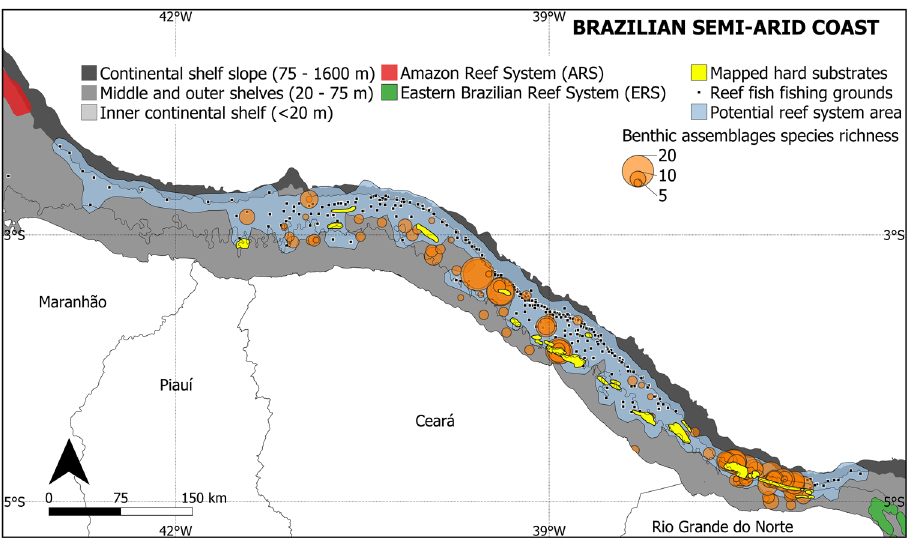
Figure 2. Distribution of euphotic and mesophotic hard-bottom habitats along the Brazilian semi-arid coast (Tropical SW Atlantic). Location data for benthic assemblages (including octocoral, scleractinian, and sponge grounds typically with reef fish assemblages) and fishing grounds obtained from the literature, scientific collections, and the monitoring of commercial fisheries (a list of data sources can be found in the supplementary materials S1). Mapped hard substrates depict known rocky-bottom environments, while benthic assemblages and fishing grounds indicate putative rocky substrates. Map made using QGIS 3.22 (https:// qgis. org/). Bathymetric data retrieved from CPRM (https:// www. cprm. gov. br/) and country area from GADM (https:// gadm.